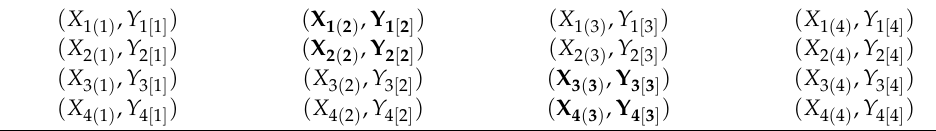
Table 1. MRSS for even sample size, i.e., n δ = 4.